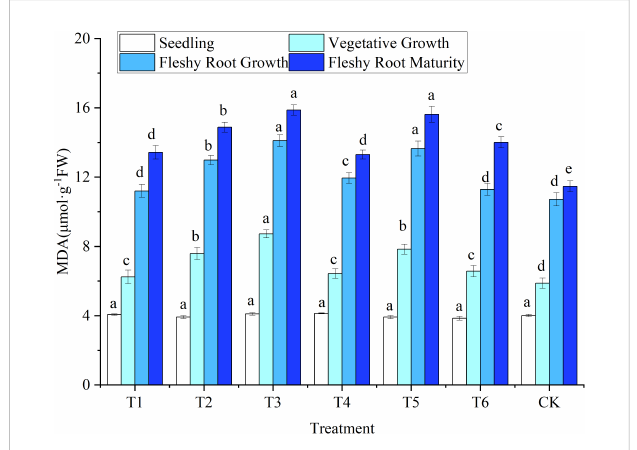
FIGURE 3 Response of malondialdehyde in woad plants in different water de fi cits. Different lowercase letters in the same column mean the signi fi cant differences among treatments according to LSD ( P < 0.05). Data were presented as mean ± SE (n = 3).